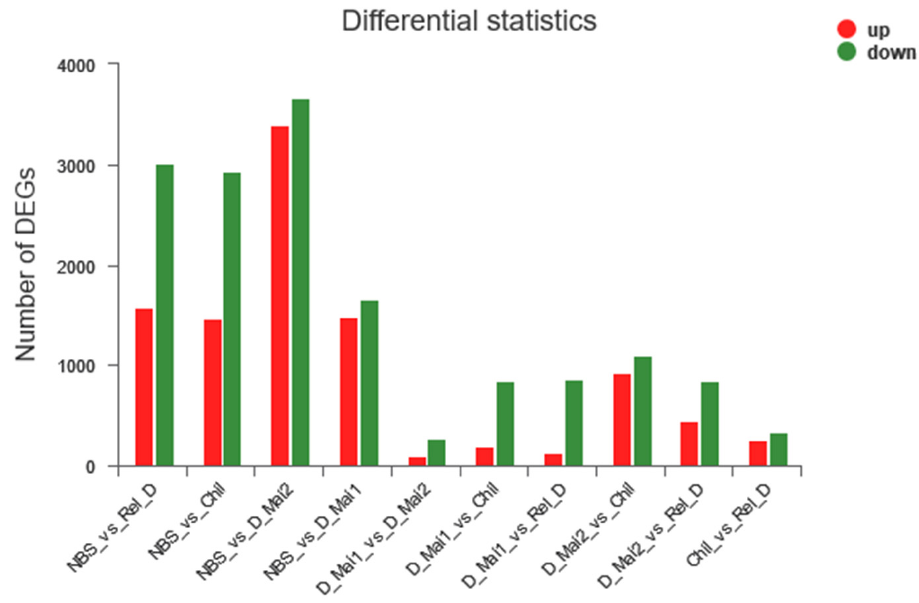
Figure 3. Statistical figure of DEGs at every two stages.